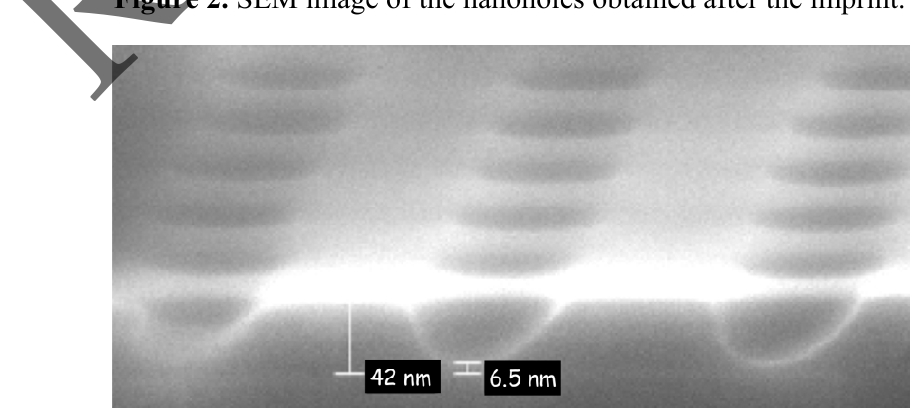
Figure 2. SEM image of the nanoholes obtained after the